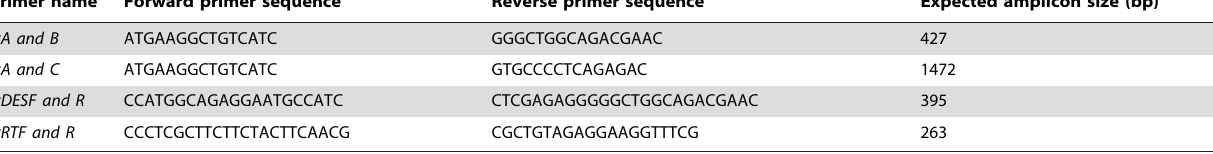
Table 1. Primers utilized in this